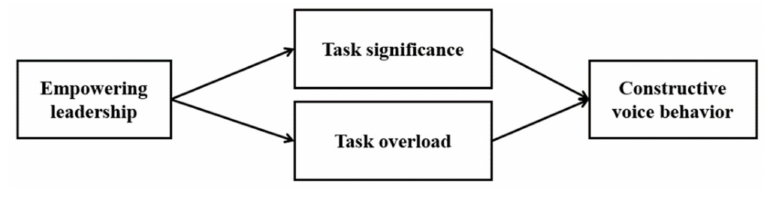
Figure 1. Research